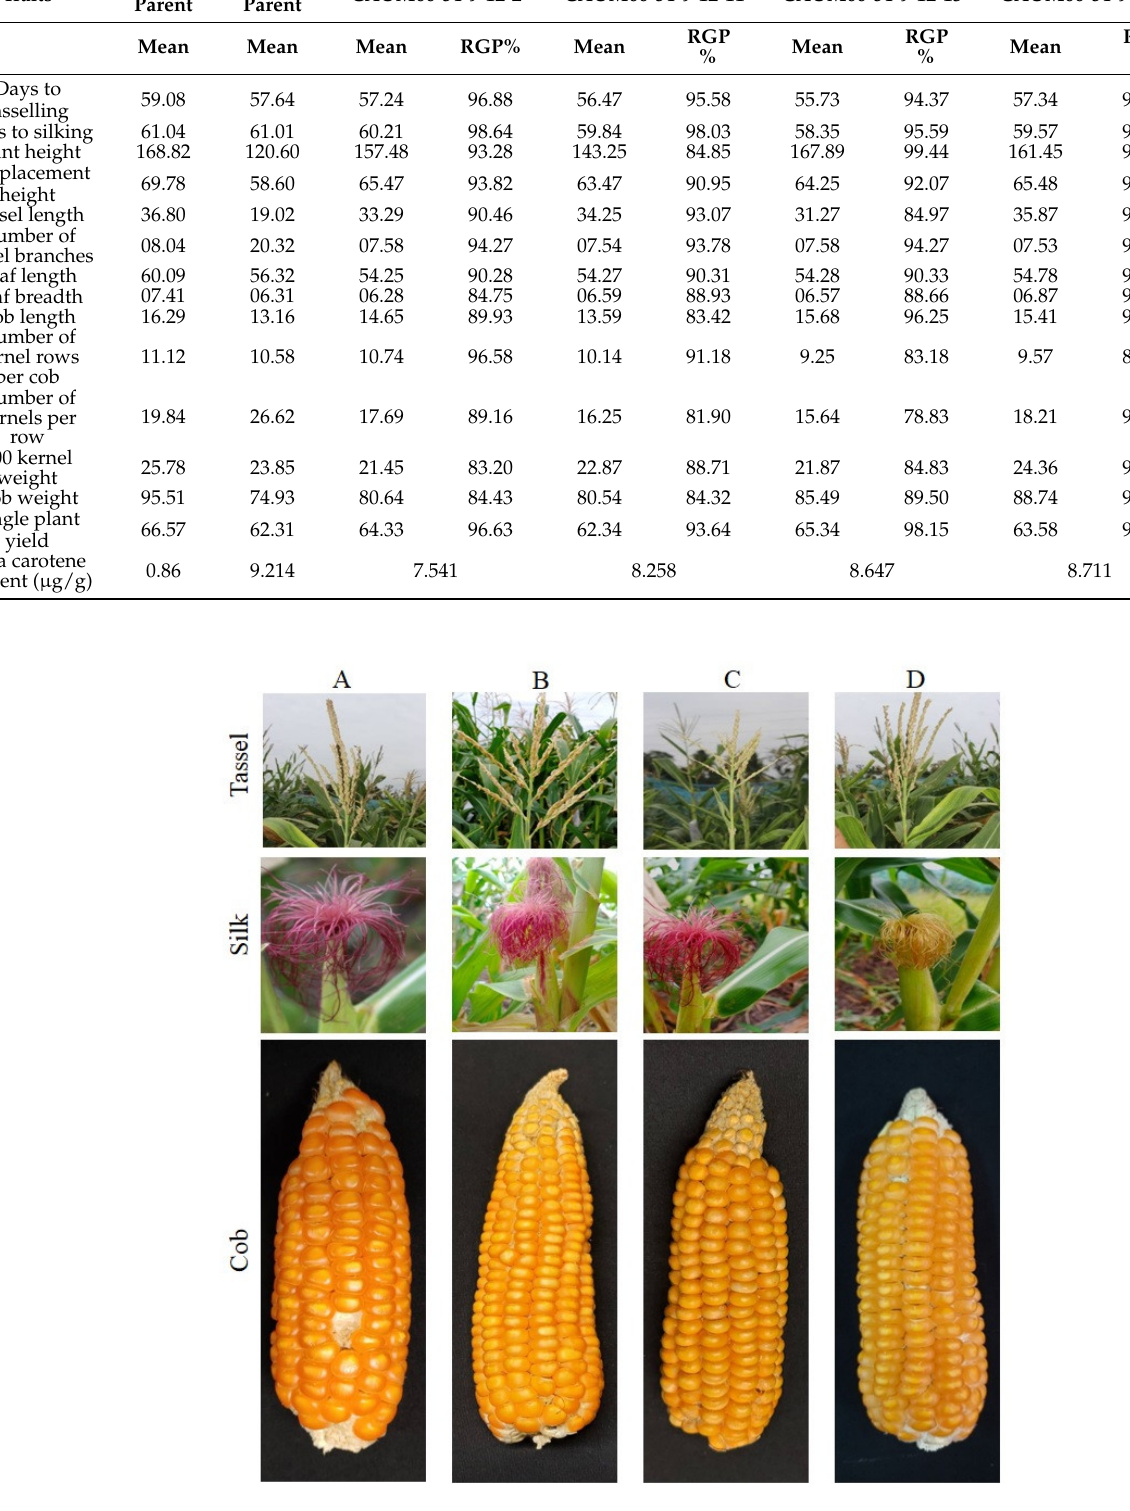
Table 3. Agronomic performance and β -carotene content of the four improved lines in BC 2 F 3 generation. S. No.